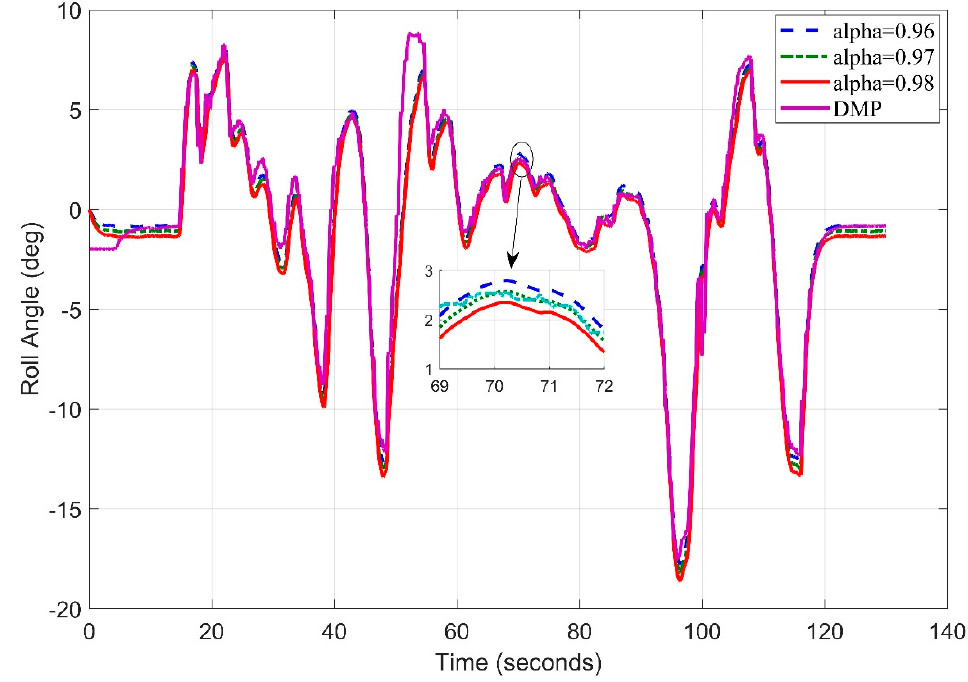
Figure 21. Real Time Roll Angle Estimate at f = 10 Hz for Complementary Filter .